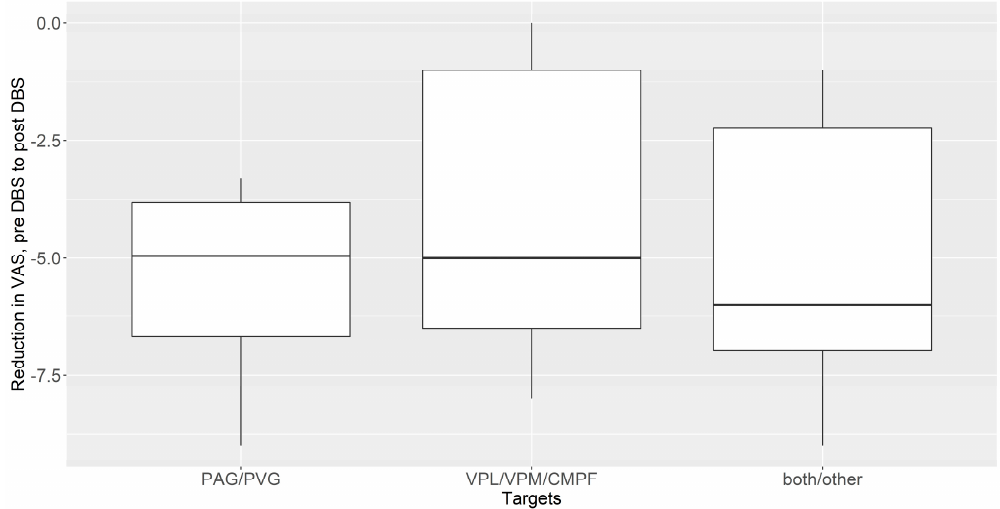
Figure 5. The subgroup analysis analyzing DBS outcomes depending on the choice of the target between PVG/PAG alone and thalamic DBS alone (VPL/VPM/CmPf) versus combined targeting. The boxplot shows the median, the upper and lower quartiles, and the two whiskers. The upper whisker extends from the upper quartile to the largest value no further than 1.5 × IQR from the upper quartile, where IQR is the inter-quartile range, or the distance between the upper and lower quartiles. The lower whisker has an analogous definition (this is Tukey’s definition of a Boxplot). Table 3. A comparison of the most frequently applied DBS targets. PVG/PAG alone versus